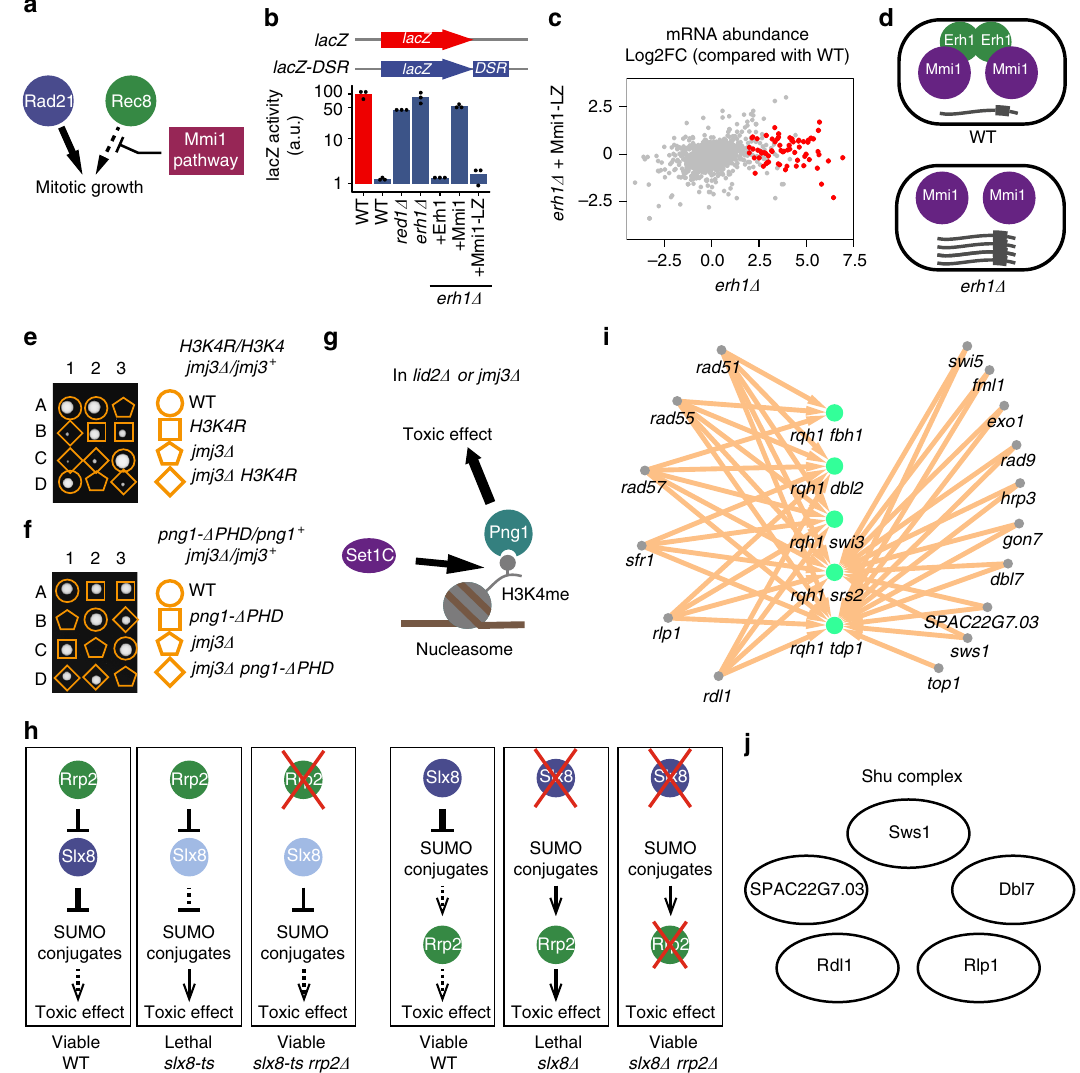
Fig. 7 Examples demonstrating the power of BOE analysis to infer gene functions. a Schematic showing the relationships between rad21 , its paralog rec8 , and the Mmi1 pathway. b Mmi1 fused with a homodimeric leucine zipper (Mmi1-LZ) rescued the gene repression defect of erh1 Δ . DSR-fused lacZ gene ( lacZ-DSR ) was used as a reporter. lacZ expressed in WT was used as a normalization control. c A scatter plot showing log2-transformed fold changes (Log2FC) of mRNA abundance relative to WT in erh1 Δ and erh1 Δ expressing Mmi1-LZ. mRNAs upregulated in erh1 Δ are highlighted in red. d A model of how Erh1 functions. e jmj3 can be bypassed by the K4R mutation in histone H3. f jmj3 can be bypassed by the PHD domain truncation of png1 . g A model depicting the Set1C-H3K4me-Png1 axis that causes the lethality of lid2 Δ and jmj3 Δ . h A model explaining how rrp2 Δ can suppress slx8-ts (left) and a model explaining how rrp2 Δ can suppress slx8 Δ (right). i BOE analysis identi fi ed 16 genes (gray nodes), when individually deleted, can suppress the lethality of at least one of fi ve synthetic-lethal double deletion mutants (green nodes). j A diagram depicting the fi ssion yeast Shu complex, including the two subunits newly identi fi ed in this